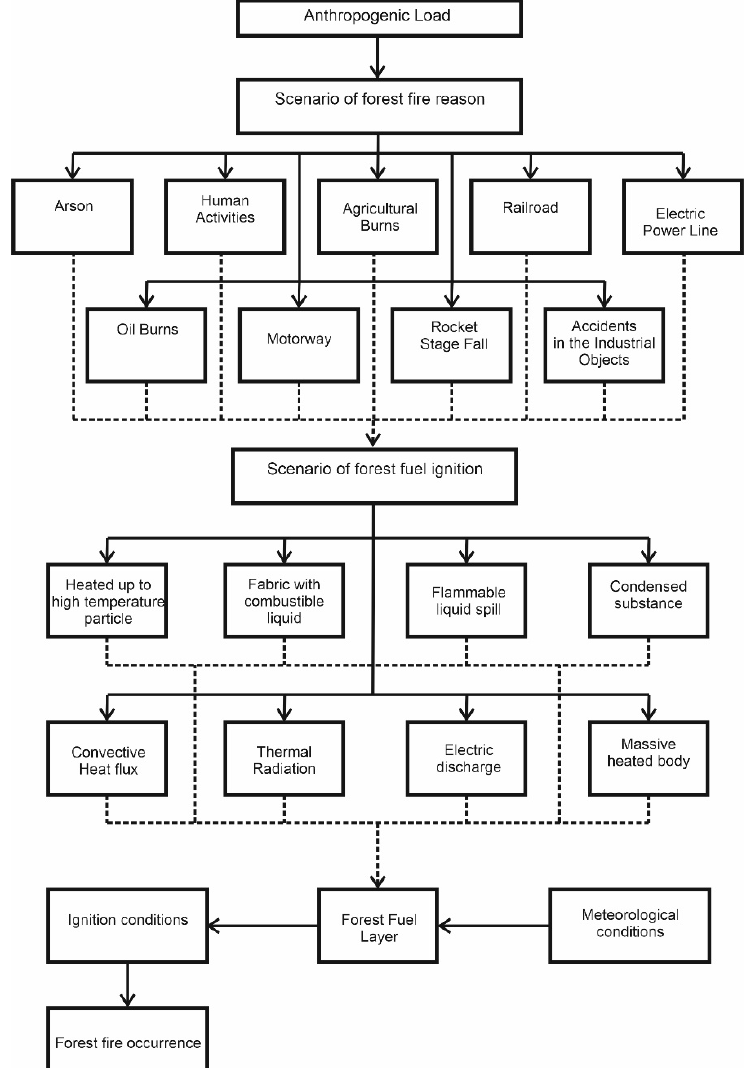
Figure 4. Ignition of forest fuel by human-made